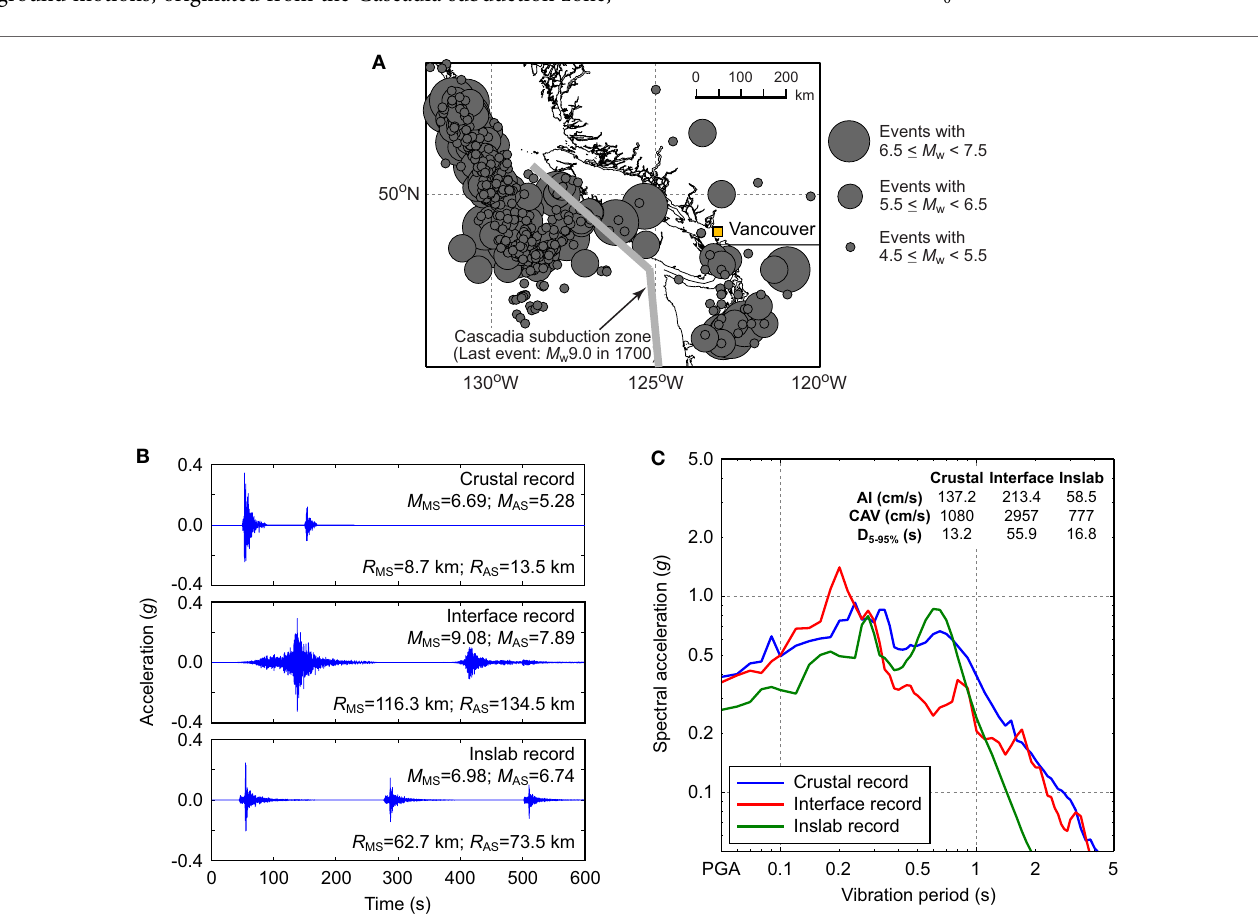
FIGURE 1 | (A) Regional seismicity in southwestern British Columbia, Canada. (B) Sample ground motion records for crustal, interface, and inslab events. (C) Five percent damped response spectra of the sample ground motion records [single horizontal component shown in panel (B) ] for crustal, interface, and inslab